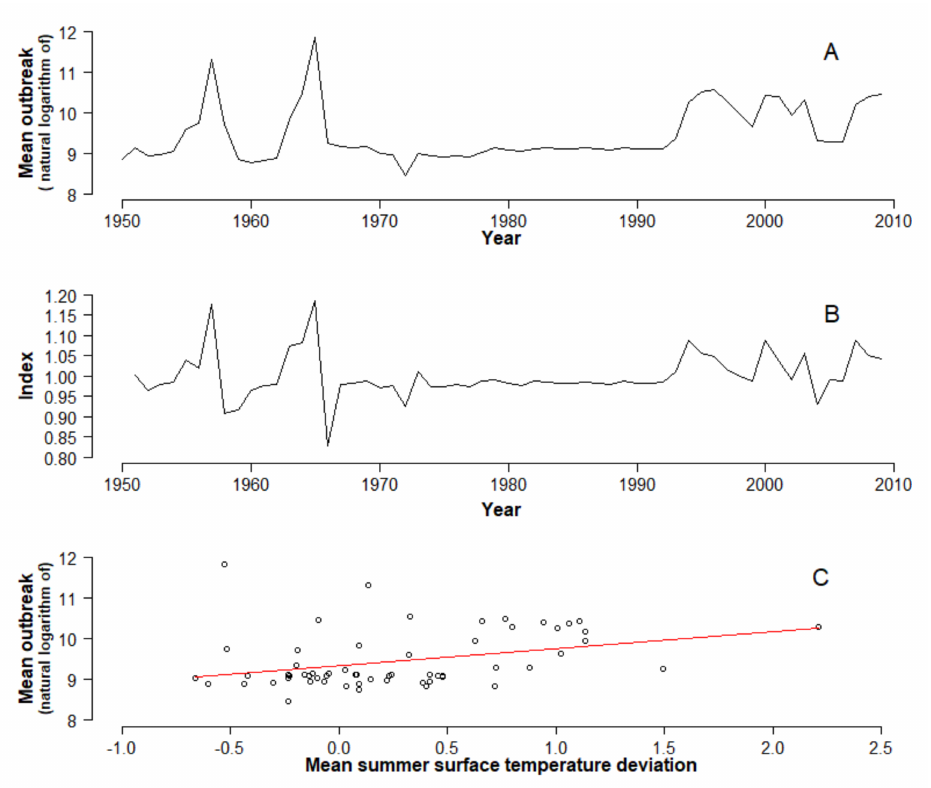
Figure 1. Area ( A ), interannual variability ( B ), and dependence of outbreak area on temperature deviation ( C ) during the period from 1950 to 2010 of the studied forest insect